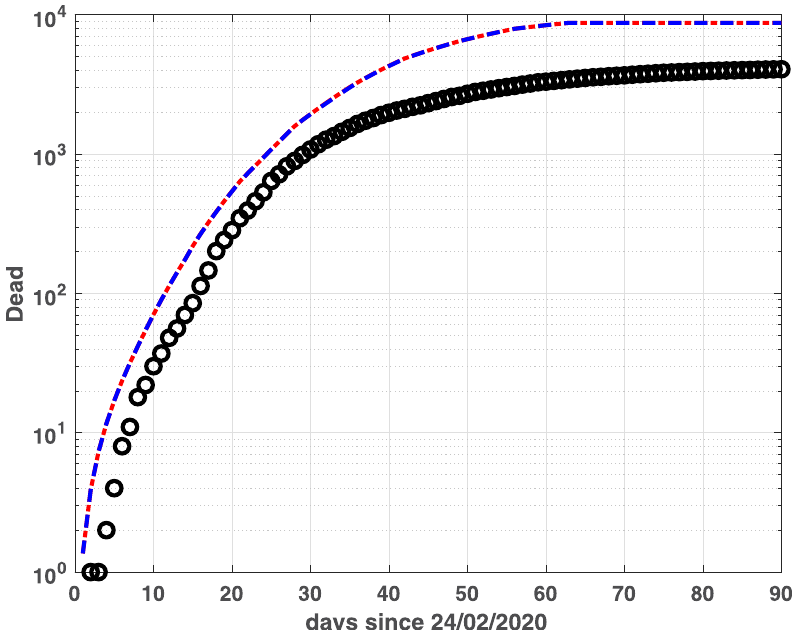
Fig 7. Recovered compartments for Emilia-Romagna. Dead data (black dots) and Dead modelled population, obtained by fSEIRDr (blue dash-dotted line) and fSEIDRe (red dashed line).